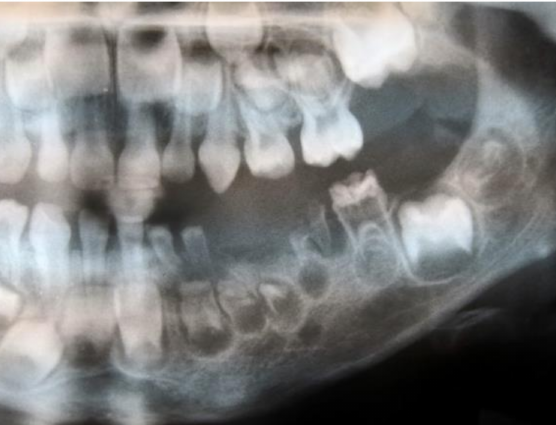
Figure 1. Fragment of the panoramic radiograph showing “ghost teeth” (in the mandibular left quadrant) characteristic of regional odontodysplasia—personal collection (K.N., Poland,